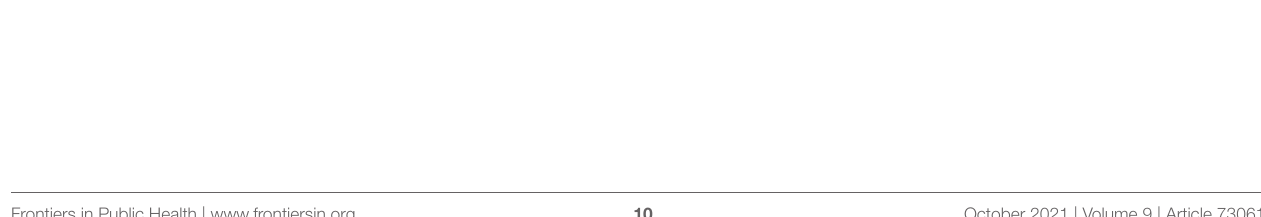
Frontiers in Public Health |